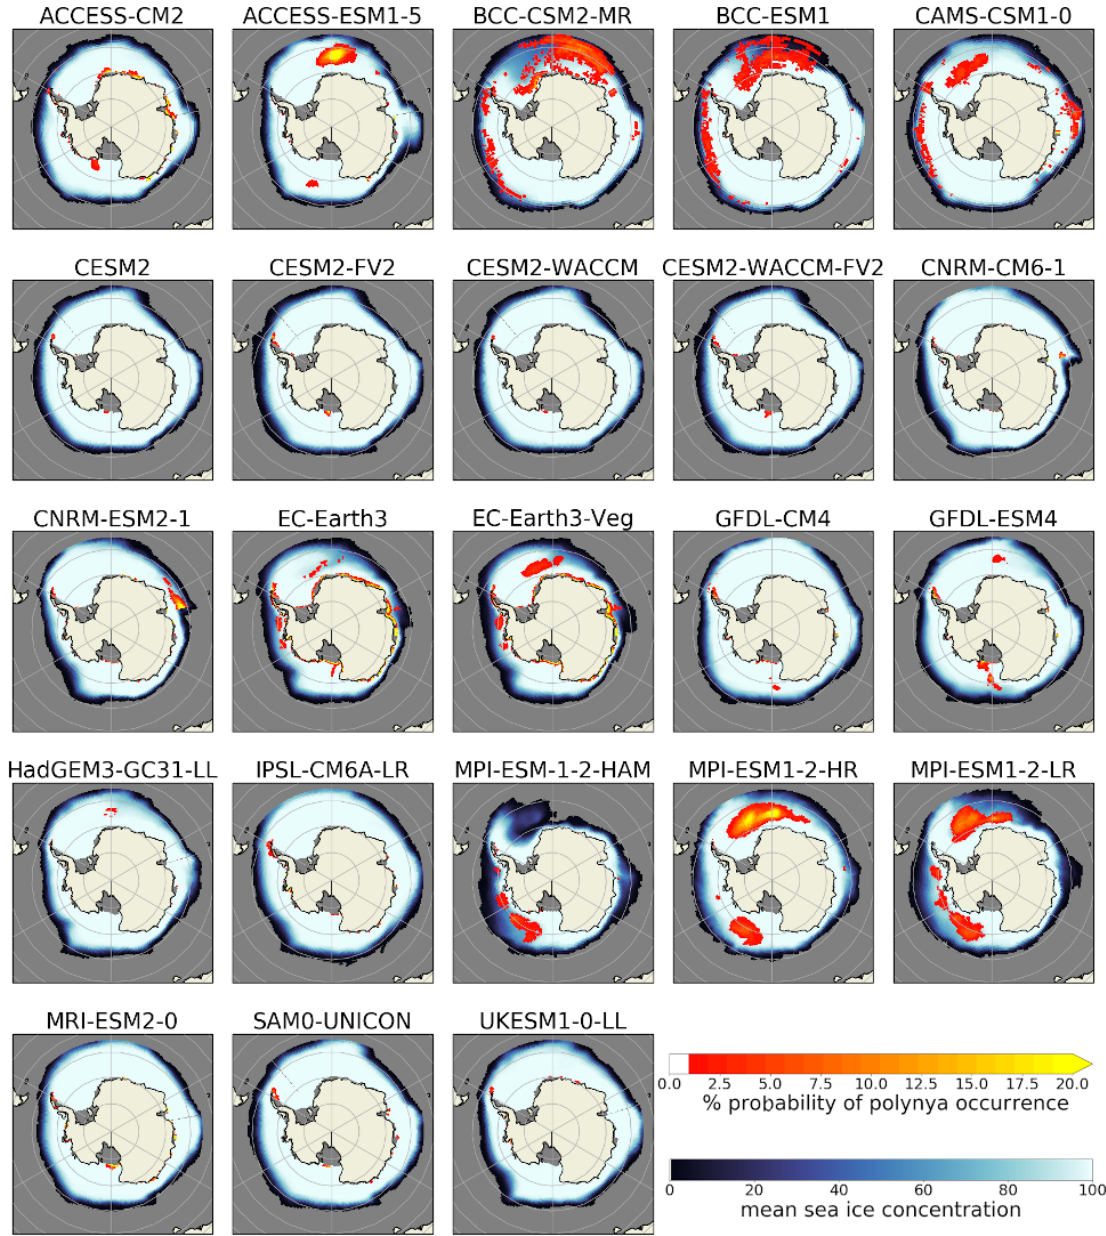
Figure 3. Spatial distribution of polynyas in the CMIP6 models, computed from the sea ice thickness output for September. The red-to-yellow colours indicate the number of years where polynyas occurred within the 165 years of the historical model run for each grid cell. The blue colours show the average sea ice concentration (in